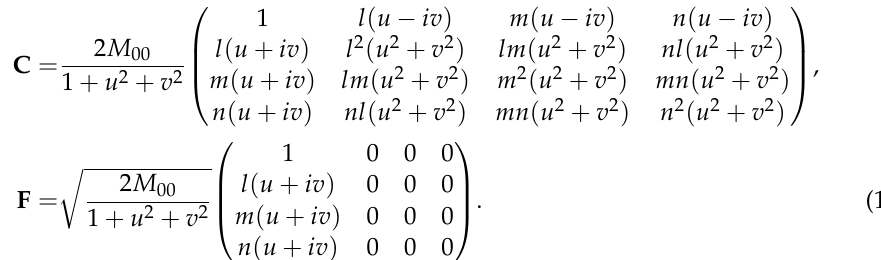
The point F = 1, u = v = 0 corresponds to free space, F = 0, u 2 + v 2 = 1 to a quarter-wave elliptic retarding diattenuater, and F = − 1, u 2 + v 2 → ∞ , to a half-wave elliptic retarder.